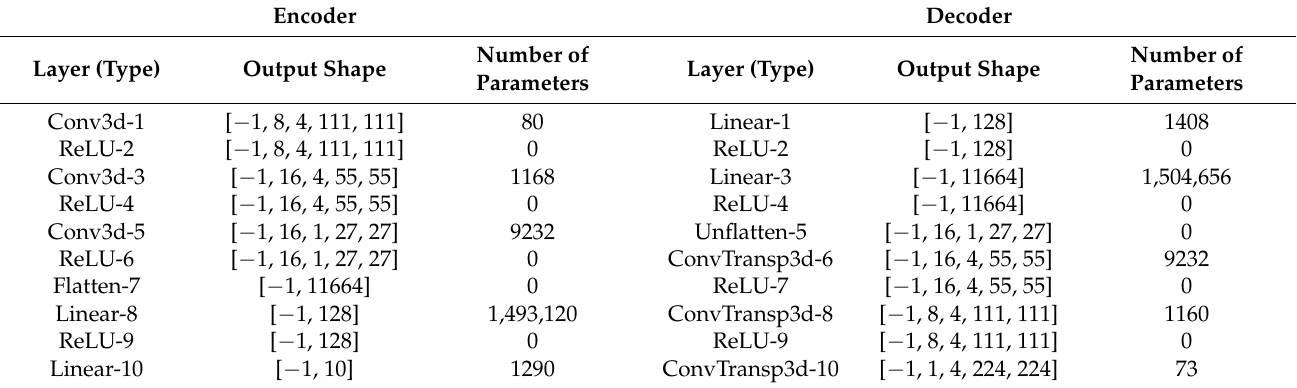
Table 4. A summary of 3D CAE network layers for processing 3D mini microstructures case study 2.